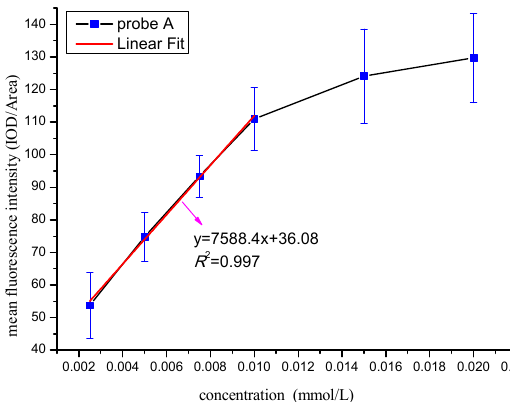
Figure 4. Effect of different concentration of probe A on the mean fluorescence intensity.